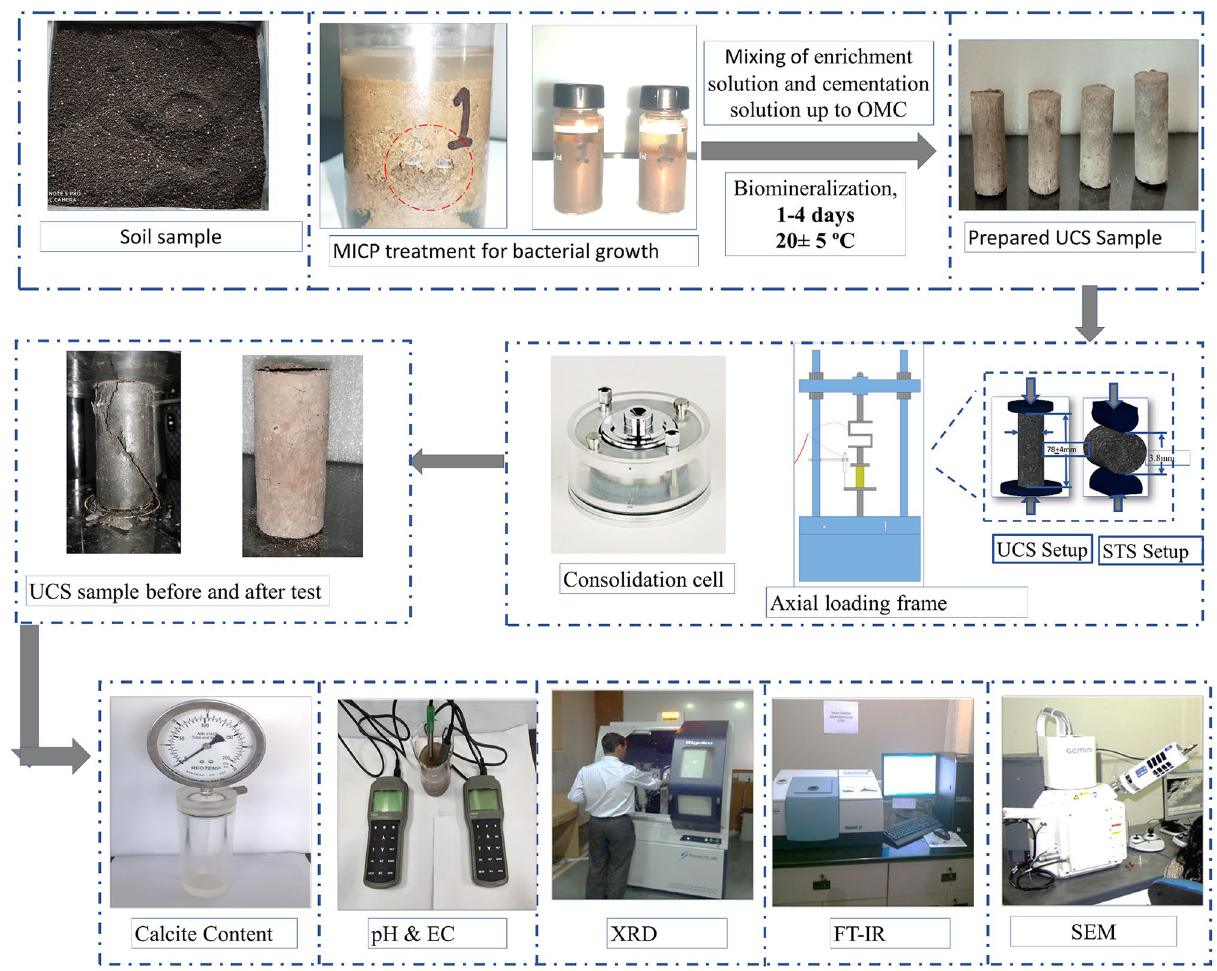
Figure 1. A detailed procedure of bacteria culturing and test setup.